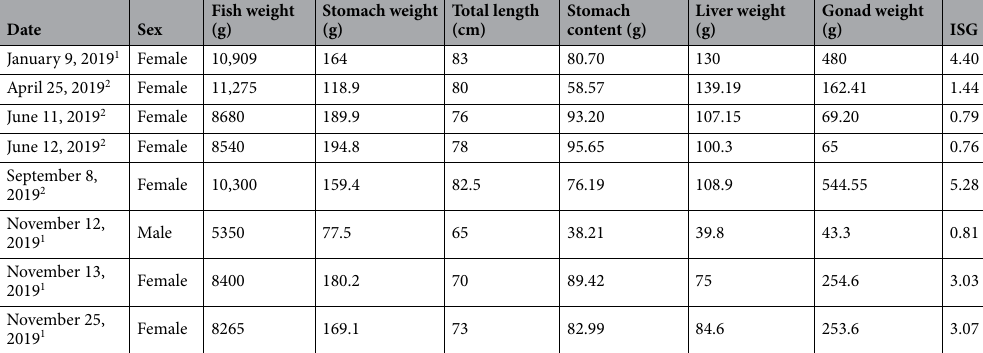
Table 1. Biological data of Acha fish ( Medialuna ancietae ) collected in Pisagua, North of Chile (19°36’S; 70°12’W), during the year 2019. 1 Samples were collected in Iquique offshore (20°13’S; 70°9’W). 2 Samples were collected in Pisagua offshore (19°36’S;